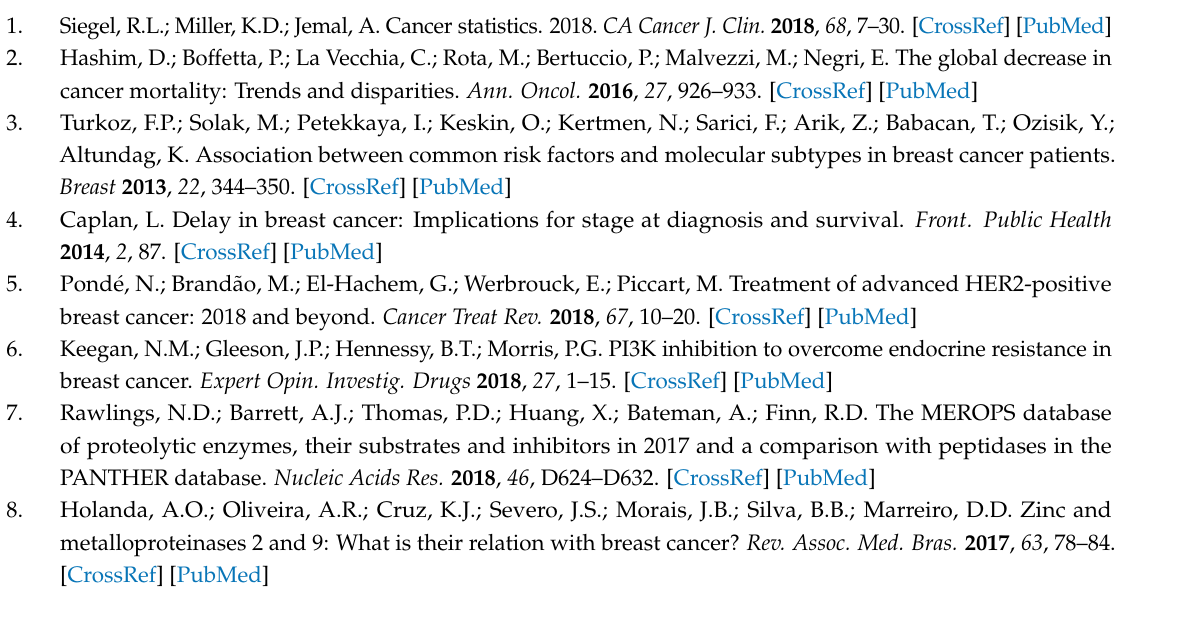
Table S1: Basic clinical parameters corresponding to 30 selected patients, Table S2: Basic clinical parameters corresponding to 80 selected patients, Table S3: List of 274 genes encoding for 458 protein spots identified on our reference proteomic map of Breast Cancer